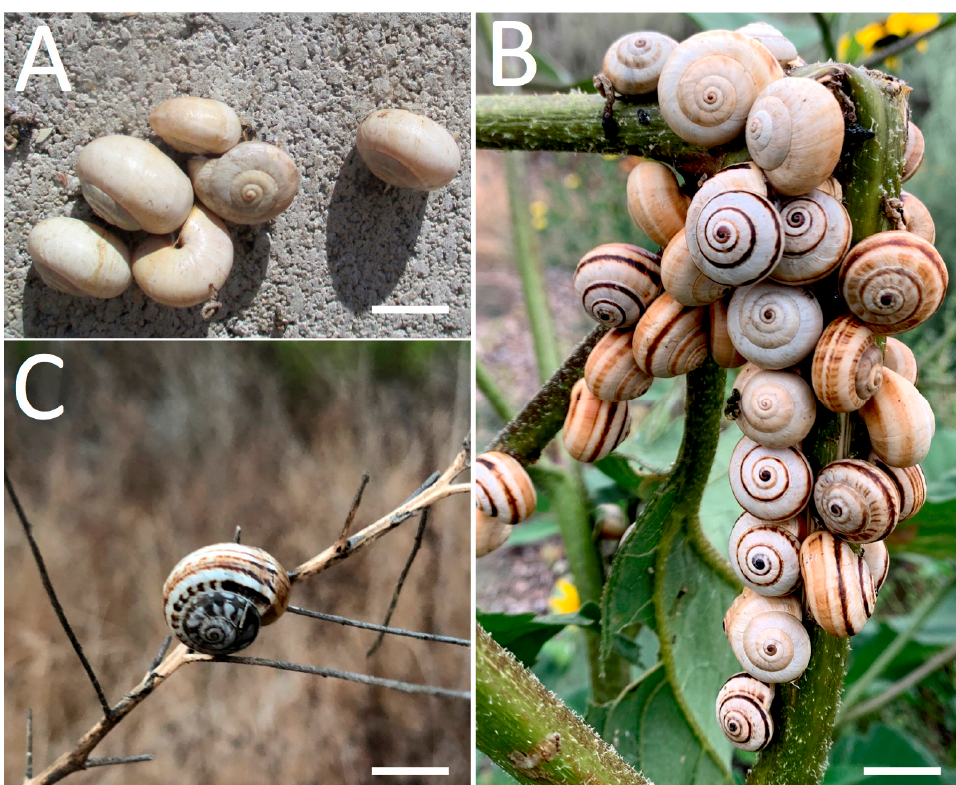
FigTree v. 1.4.3 [65]. Nodes were labeled with maximum likelihood (RAxML) bootstrap support values ≥ 75, followed by Bayesian posterior probabilities ≥ 0.90.